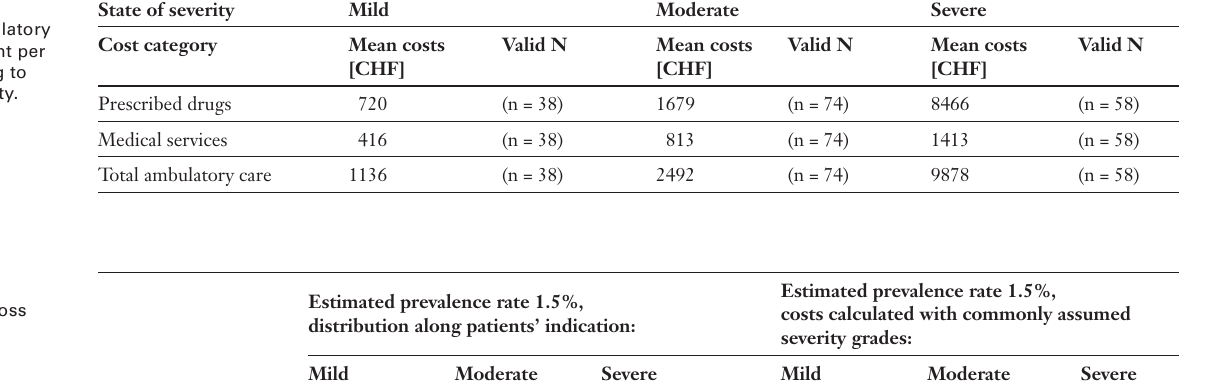
Total costs across all categories of severity in